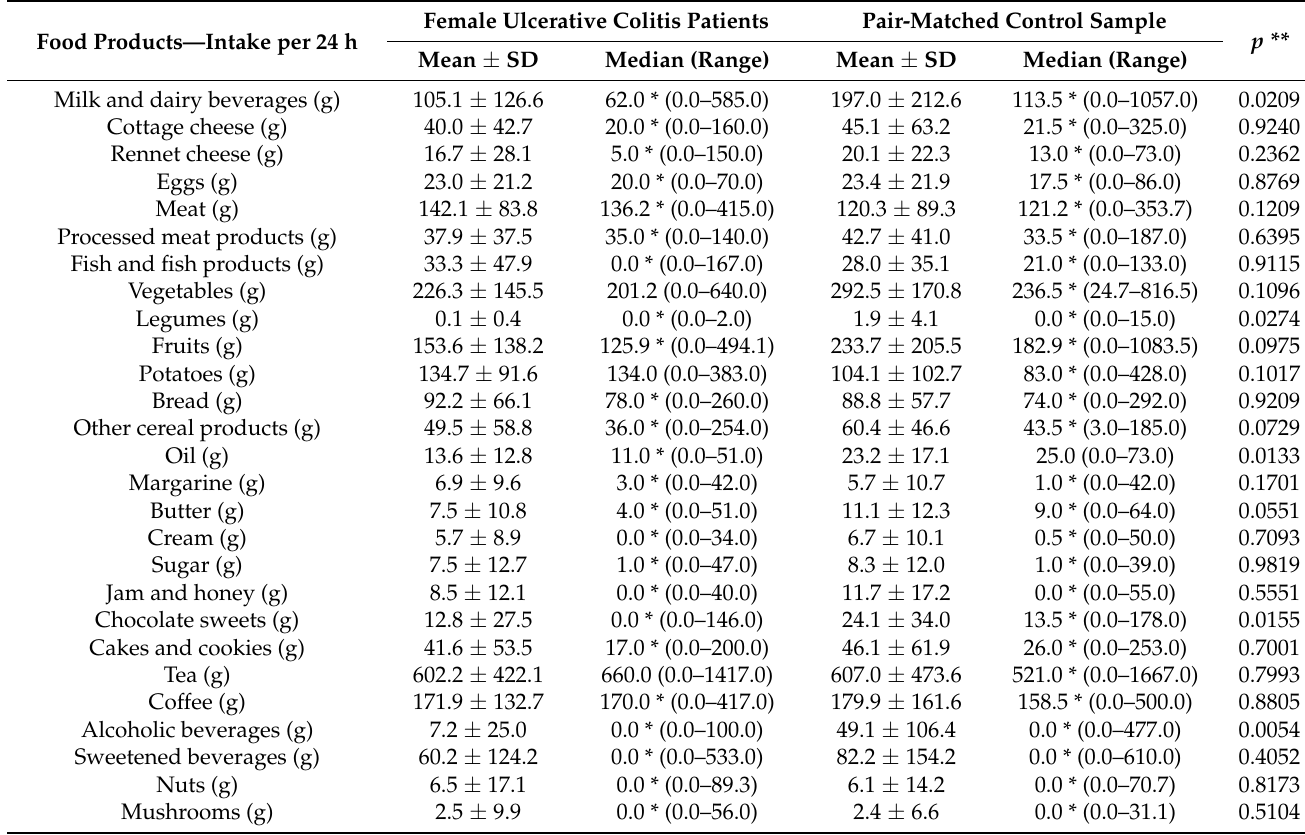
Table 7. The food products intake in the studied Polish female ulcerative colitis individuals, in comparison with a pair-matched control sample.